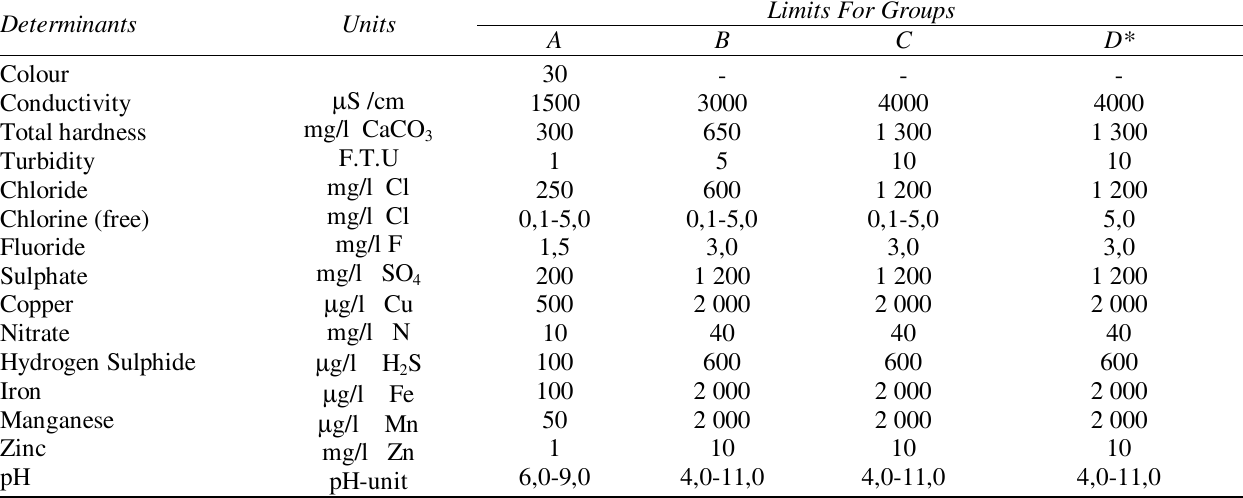
Table 7: Determinants with aesthetic/physical